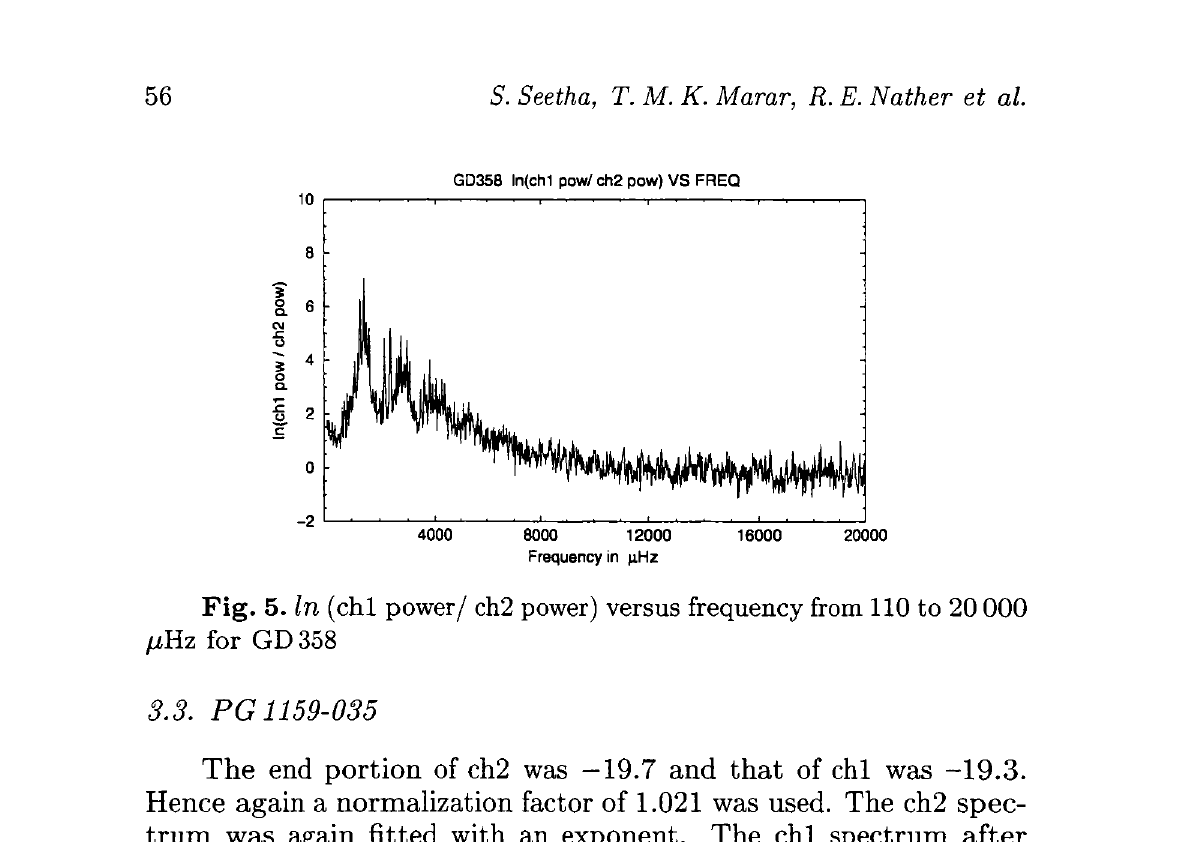
Fig. 5. In (chl power/ ch2 power) versus frequency from 110 to 20 000 ¿/Hz for GD